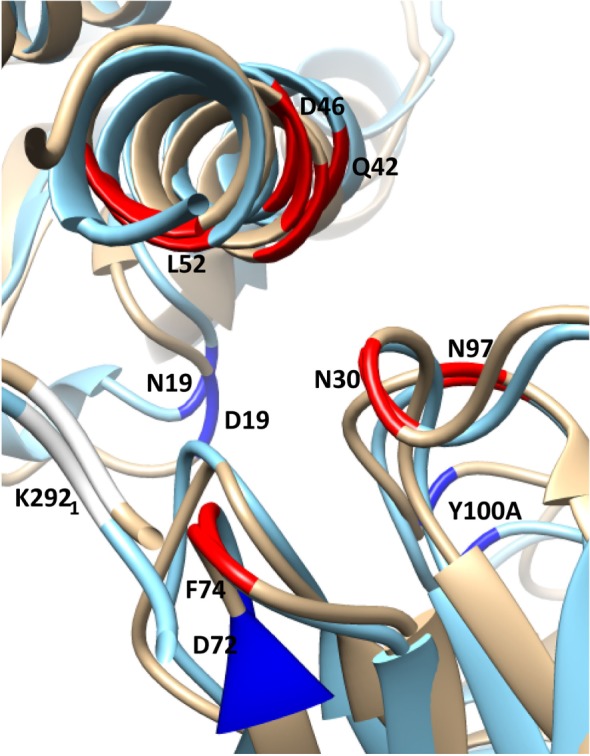
Selected residues with significant ΔΔGbind in the substitution D19N in the CR9114/H3N2 complex (wild-type chains are in gold, superposed with the substituted complex in blue). HA chains are in the top-left corner, Ab chains bottom-right. The structure is viewed along the axis of Helix A, looking toward the viral membrane. The locations of selected residues with stronger interaction in the presence of the substitution are shown in highlighted in red, weaker in dark blue. The weaker interaction between HA2 N19 and CDR3 Y100A allows the antibody’s orientation to shift anticlockwise along the Helix A axis, bringing CDR residues N30, N31, and N97 into closer contact with Helix A residues D46 and Q42. Furthermore, membrane-proximal Ab residues move away from Helix A, while membrane-distal residues move toward it. This latter adjustment weakens the interaction between HA1 K292 and FR3 D72, while strengthening interactions between FR3 F74 and HA1 K292, HA2 L 52.